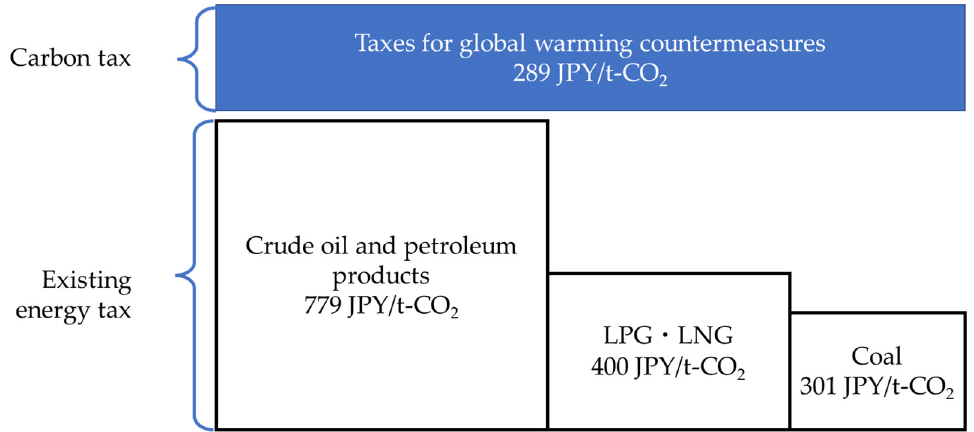
Figure 1. Tax rate per CO 2 emission unit (JPY/t-CO 2 ). Source: Ministry of the Environment [4] .